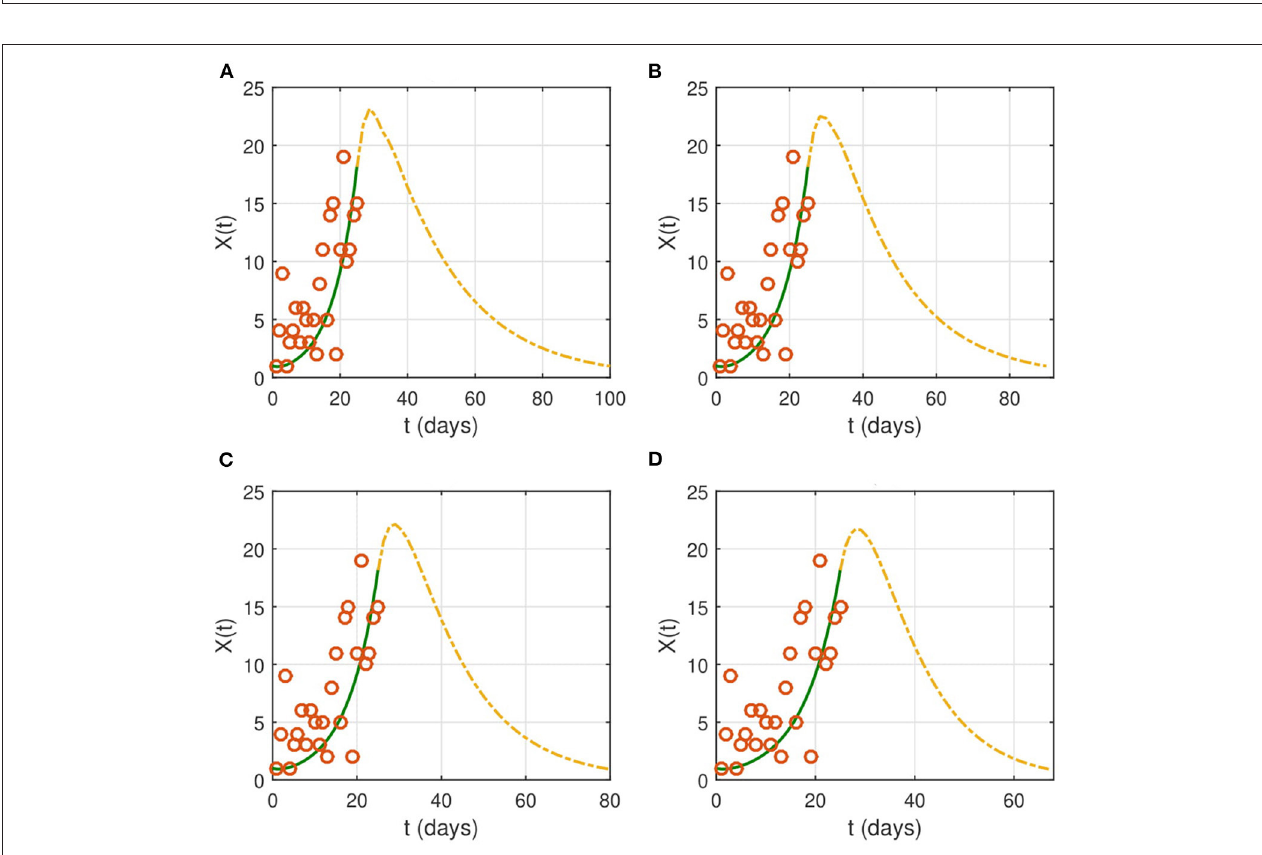
FIGURE 3 | The effect of NPIs on the evolution of the identification function X ( t ). Lockdown starts on from April 1, 2020 ( t = 26). We choose the following values for the contact rate: (A) β new = 0.1 × β , (B) β new = 0.08 × β , (C) β new = 0.05 × β , and (D) β new = 0.001 × β . The time interval of the X-axis represents the duration of the epidemic. The red circles represent the data for the number of reported